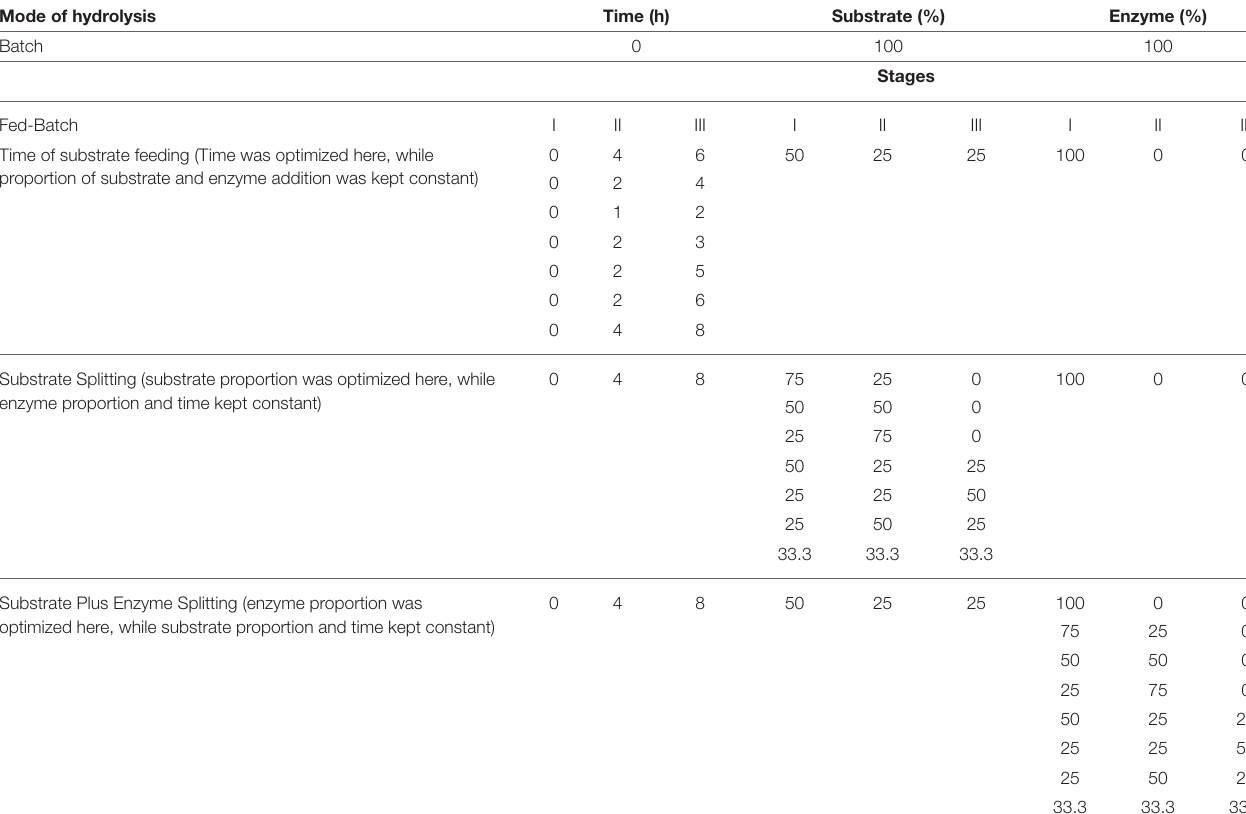
TABLE 1 | Experimental scheme for optimization of fed-batch variables. Mode of hydrolysis Time (h) Substrate (%) Enzyme (%) Batch 0 100 100